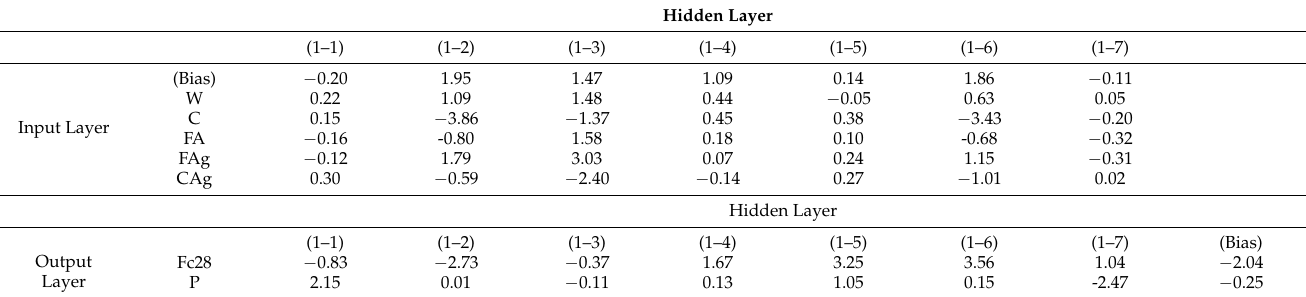
Figure 4. Relative importance of input parameters.